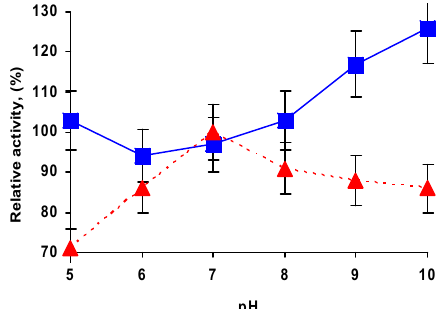
Figure 1. E ff ect of the pH value on p -NPB activity of CALA (red triangles) and CALA-MNP (blue squares). Further details are given in Section 3. 100% is considered the activity of the free enzyme at Figure 1. Effect of the pH value on p ‐NPB activity of CALA (red triangles) and CALA‐MNP (blue pH 7 (optimal conditions for the enzyme), and correspond to around 210 U / squares). Further details are given in Section 4. 100% is considered the activity of the free enzyme at pH 7 (optimal conditions for the enzyme), and correspond to around 210 U/mg.